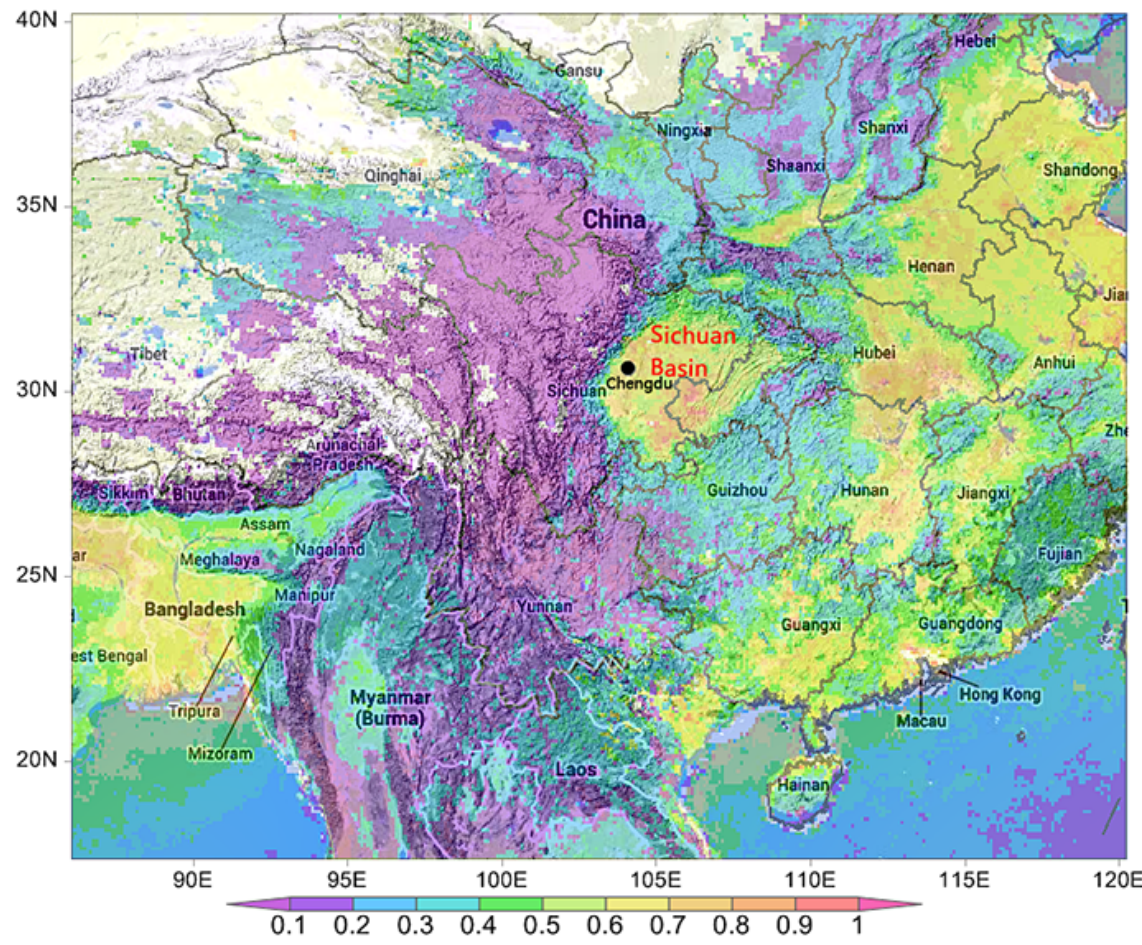
Figure 1. Sampling location (30.65 ◦ N, 104.03 ◦ E) in Chengdu on a regional map superimposed with spatial distribution of annual mean aerosol optical depth (AOD) retrieved from Moderate Resolution Imaging Spectrometer (MODIS) satellite remote sensing in